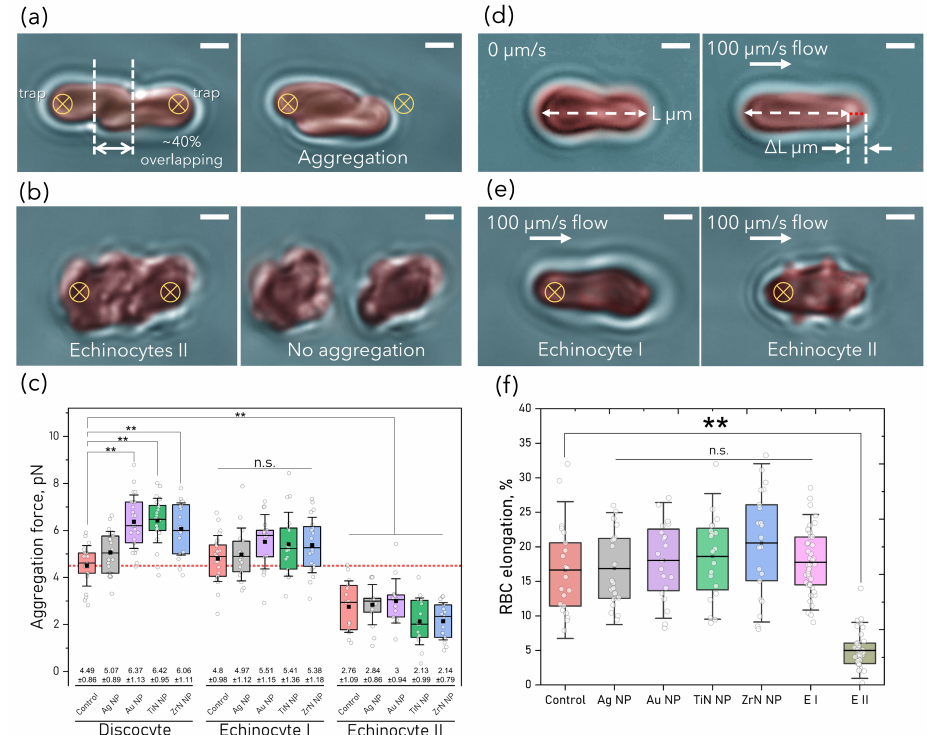
Figure 4. ( a ) OT measurements of RBC aggregation force after treatment with NP (50 µ gmL − 1 ) for ( a ) discocytes and ( b ) echinocytes II. RBC relative elongation in fluid flow (100 µ m/s) for ( d ) discocyte and ( e ) echinocytes I and II. Scale bar: 2 µ m. ( c ) Box plot of RBC aggregation force and ( f ) scatter interval plot of relative RBC elongation in viscous flow 100 µ m/s. Data are expressed as mean ± SD, n = 20–30, ** p < 0.05, ns: non-significant, in one-way ANOVA, followed by Tukey’s post hoc test compared to control. Center lines show the medians; square dots represent the means; outliers and individual data points are represented by dots; box limits indicate the 25th and 75th percentiles; whiskers show